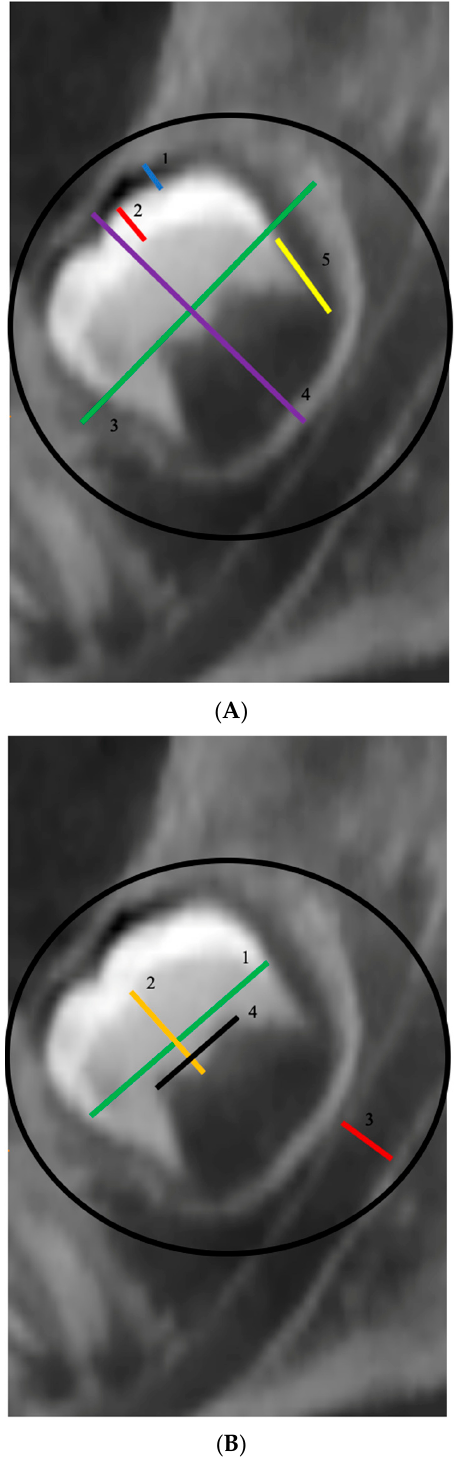
Germ. 1. JEC diameter. 2. Dentin thickness. 3. Alveolar channel diameter. 4. Pulp chamber